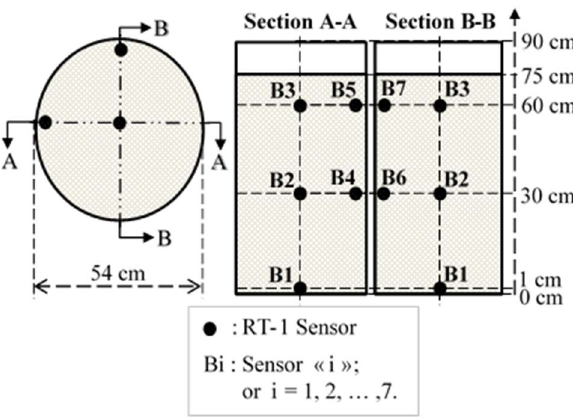
Figure 3. Barrel instrumentation with RT-1 sensors (plan view and vertical section views).